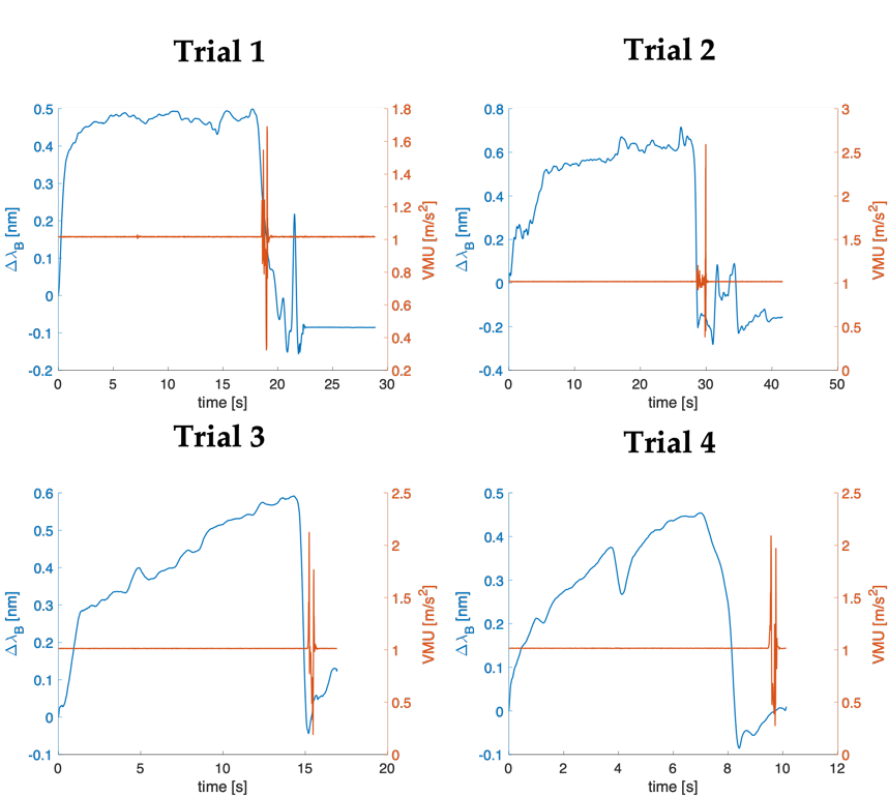
Figure 7. ∆λ B (blu lines) and VMU (orange lines) signals as a function of time expressed in s for each of the patients enrolled (i.e., Trial 1, 2, 3, and 4).